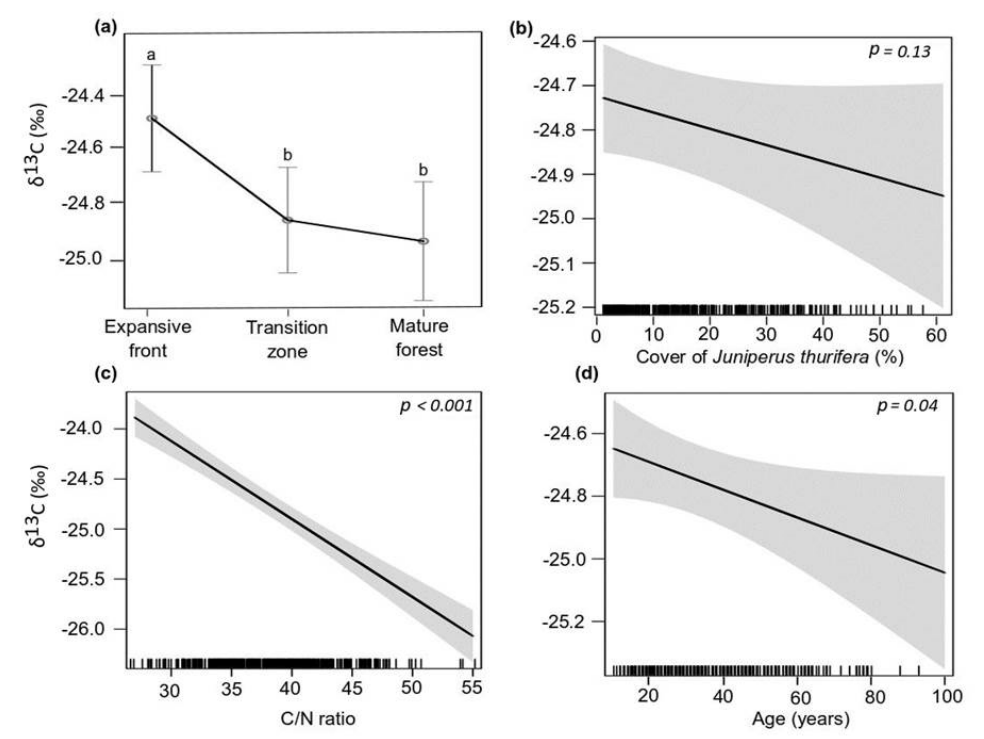
Figure 3. Model prediction for ( a ) the effect of the stage of forest expansion gradient, ( b ) the effect of the cover of conspecifics, ( c ) the effect of tree age, and ( d ) the effect of C/N ratio in leaves on δ 13 C. Different letters indicate significant differences ( p < 0.05).